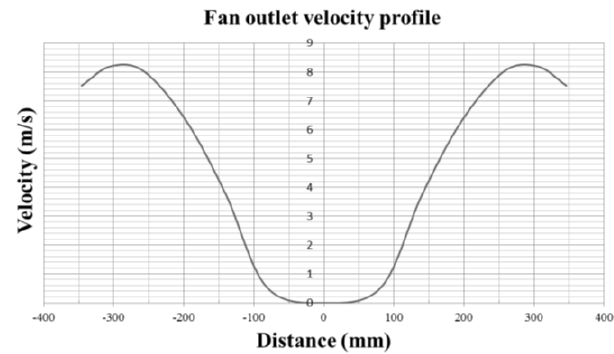
Figure 4. Exhaust fan velocity profile.